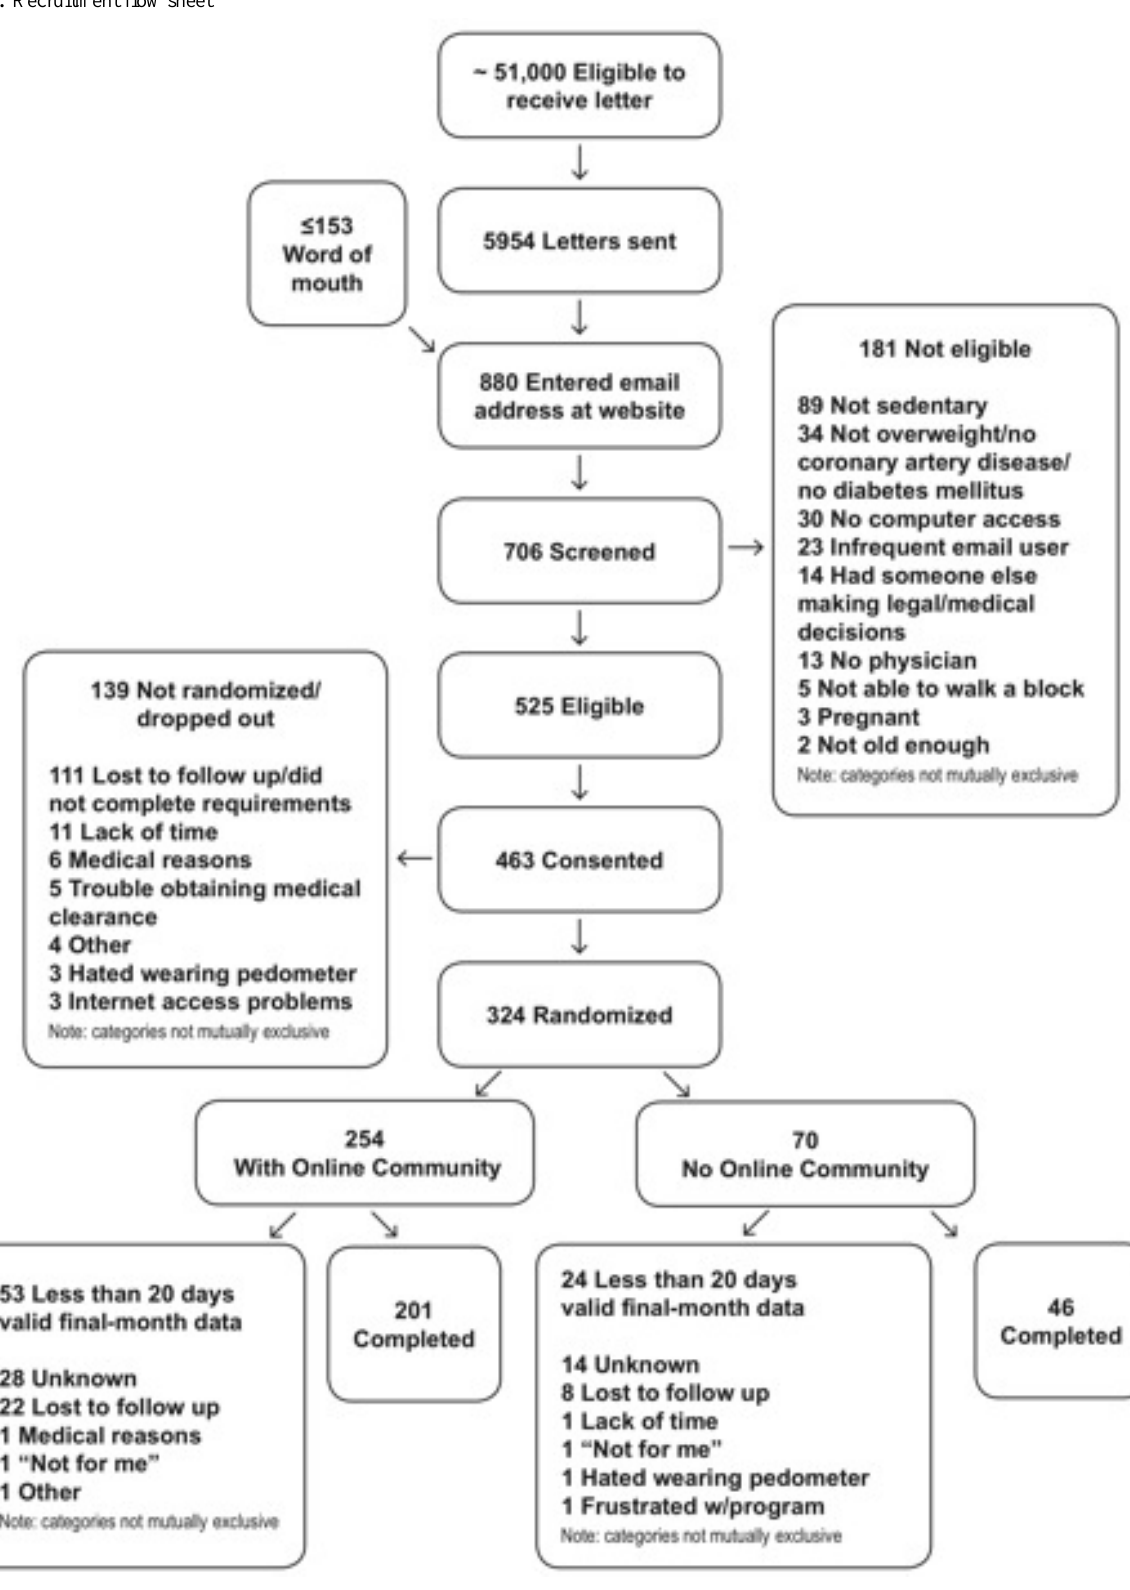
Figure 3. Recruitment flow